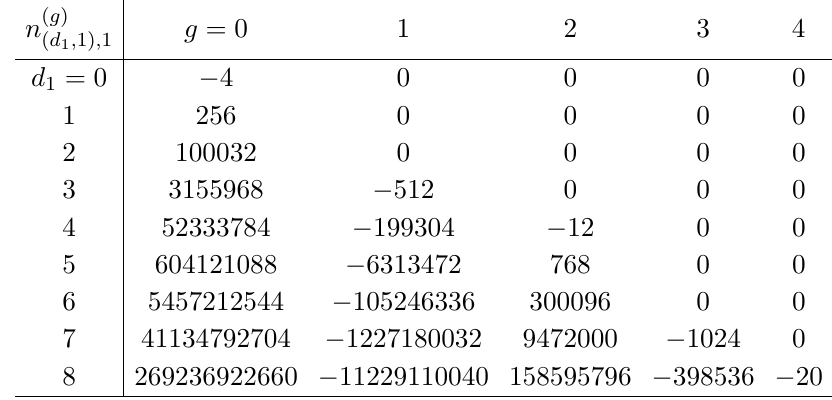
with Z charge 1 . 2 2